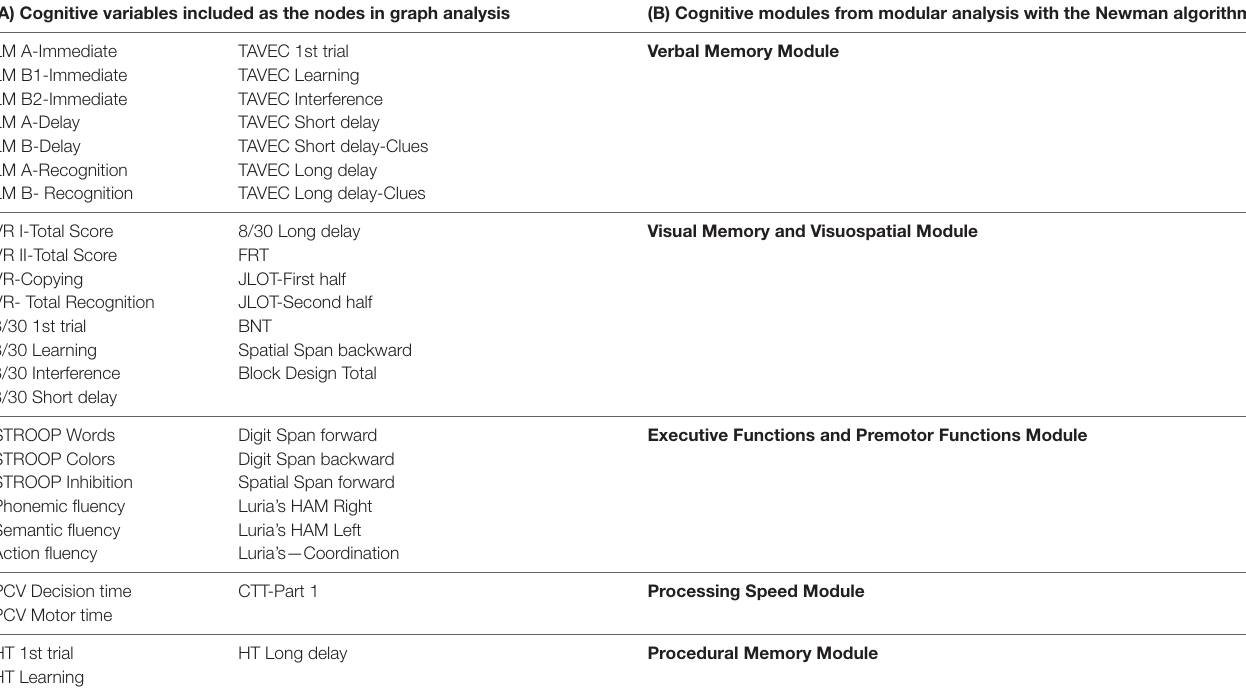
TABLE 1 | Cognitive variables and cognitive modules. (A) Cognitive variables included as the nodes in graph analysis (B) Cognitive modules from modular analysis with the Newman